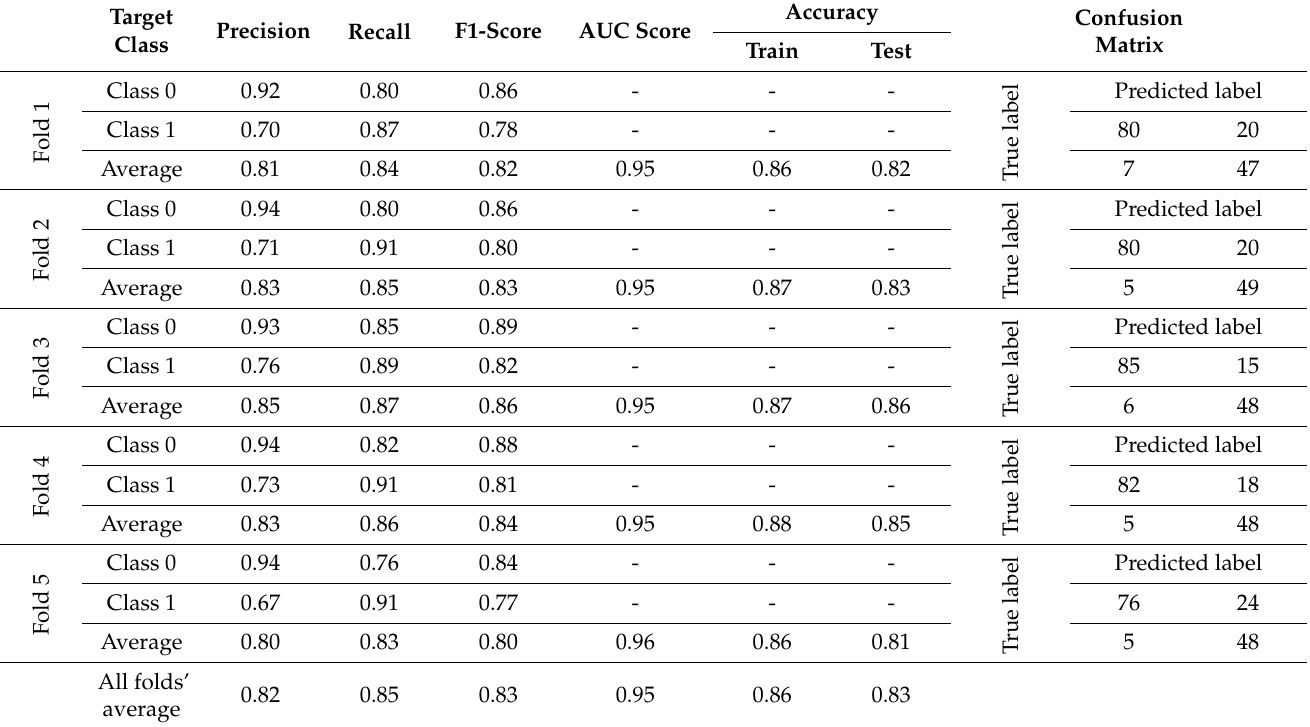
Table A6. AdaBoost classifier’s performance for the five-fold cross-validation.